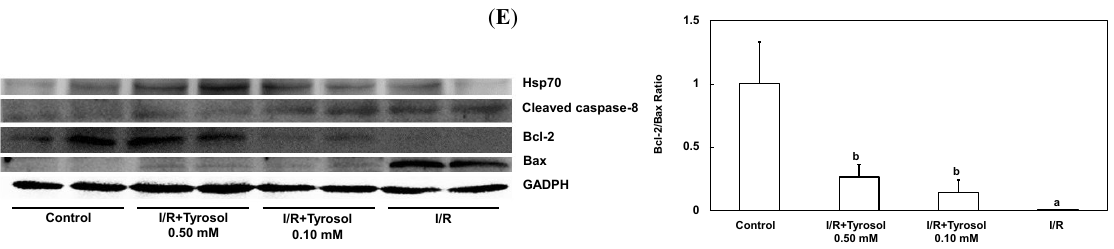
Figure 5. Effect of tyrosol on protein expressions in H9c2 cardiomyocytes during I/R. Cells were incubated with tyrosol (0.10 and 0.50 mM) before and during I/R, and